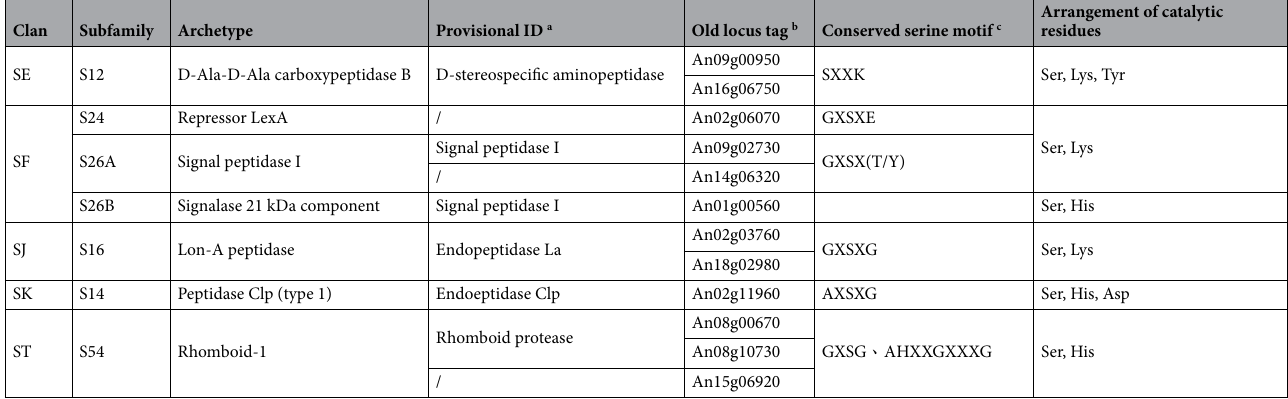
Table 6. Serine proteases encoded by A. niger strains CBS 513.88 and ATCC 1015. a /, not provisionally identified; b Proteases that have been molecularly and/or biochemically characterized are in bold; c The putative catalytic residues are colored in pink; X represents any amino acid; * Secreted proteases that have been predicted by the six predictors, the unassigned extracellular serine proteases An02g01550 and An07g00580